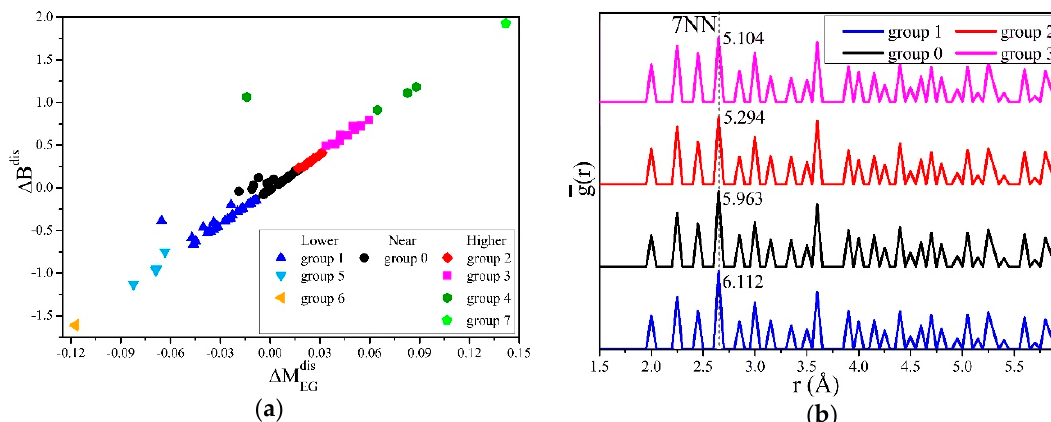
Figure 6. Clustering and averaged partial PCF analysis for the hydrogen distribution e ff ects on ∆ B dis . ( a ) Mean-shift clustering for ∆ B dis , with an x axis of ∆ M dis , transformed using Equation (16). ( b ) The averaged partial PCF g ( r ) for structures in clustered groups. ∆ B dis decreased with the hydrogen atoms distributed in the 7NN.